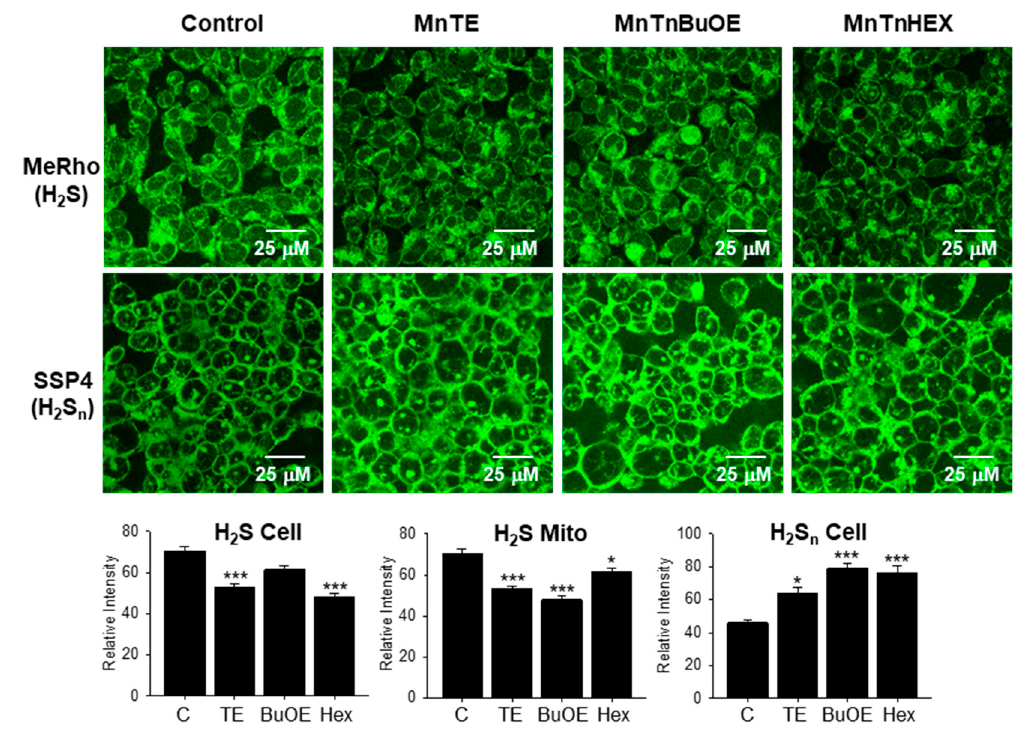
Figure 3. Confocal micrographs showing the e ff ects of 1 µ M MnPs on H 2 S (MeRho-Az fluorescence) and polysulfides (H 2 S n ; SSP4 fluorescence) in HEK 293 cells. H 2 S fluorescence is reduced in MnTE and MnTnHex cells and in all MnP-treated mitochondria, whereas polysulfide fluorescence is greater in all MnP-treated cells. Micrographs uniformly enhanced for clarity, bar graphs from original, unaltered micrographs, mean + SE, n = 15 cells; *, p < 0.05 ; ***, p < 0.001 .